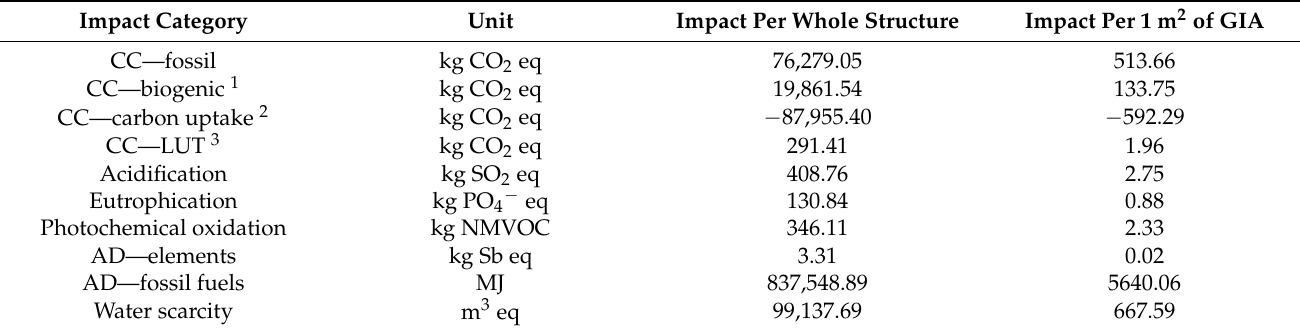
Table 2. Total life cycle impact assessment results.